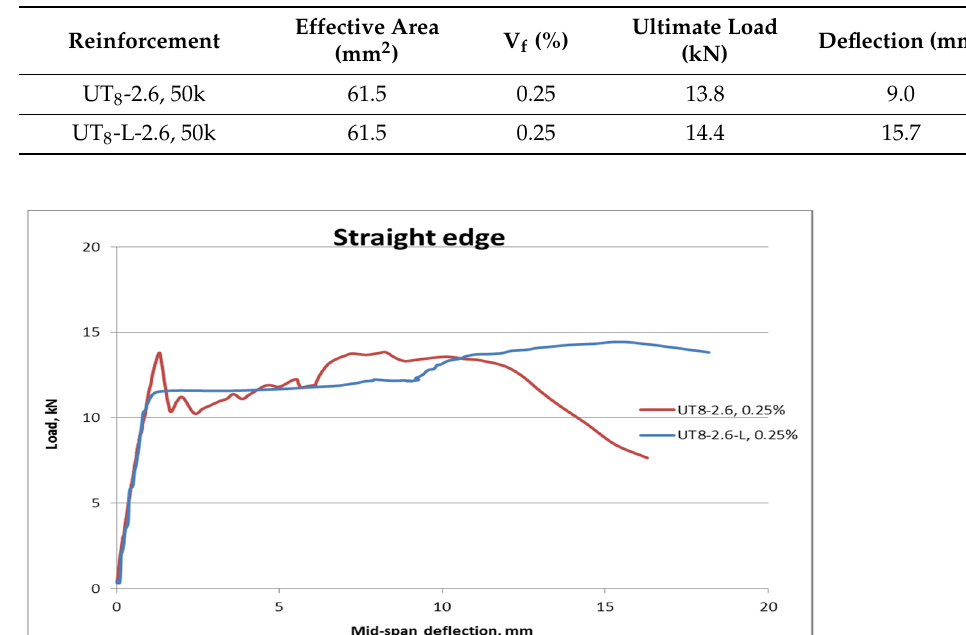
Figure 10. Mid-span load-deflection of straight end tow uni-axial TRC beams at different layers.